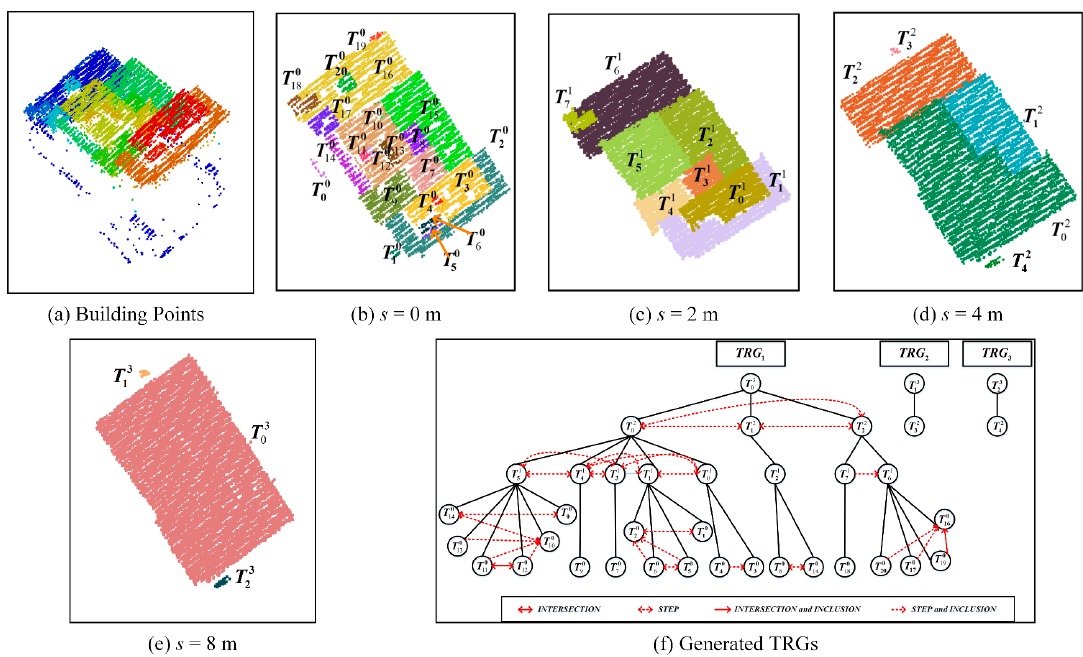
Figure 11. Generating the scale space and the corresponding TRG for a building candidate region PB in Figure 10c. ( a ) Point clouds of the building candidate region; ( b – e ) Segmentation results at four scales, where different segments are dotted in different colors. Additionally, each segment is annotated with a unique identification; ( f ) Generated TRGs.